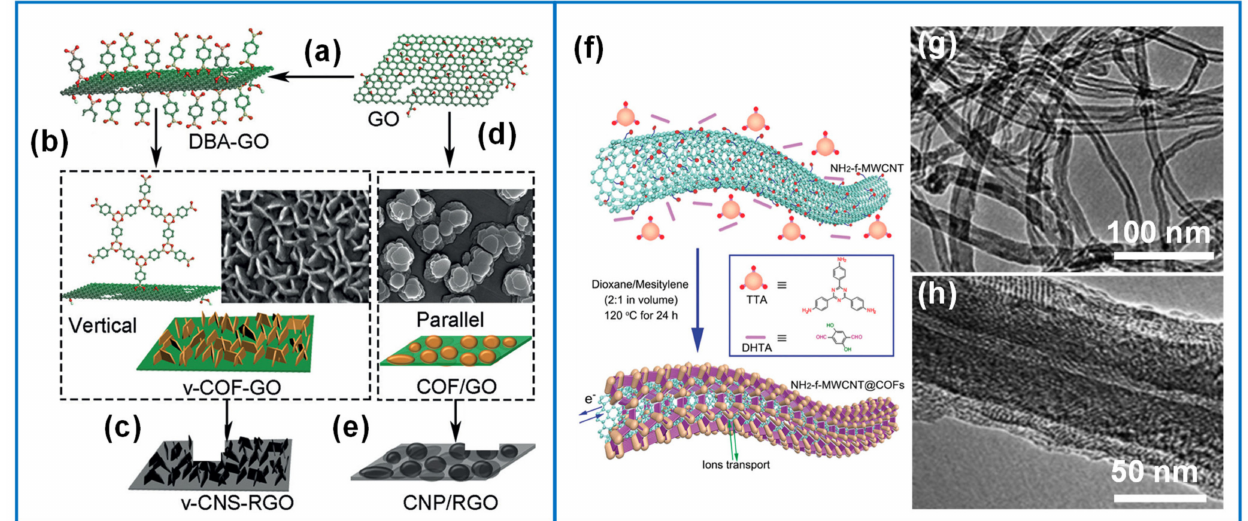
Figure 15. ( a ) Functionalized GO with DBA in methanol. ( b ) Vertical COF nanosheets growth using DBA functionalized on GO dissolved in mesitylene/dioxane (v-COF-GO). ( d ) Parallel COF platelets to GO formation without DBA (COF/GO). Carbonization of ( c ) v-COF-GO and ( e ) COF/GO to produce vertically oriented nanosheets (v-CNS-RGO) or parallel to RGO surface (CNP/RGO). ( f ) Schematic of COFTTA–DHTA shells on the NH 2 -f-MWCNT surface. COFTTA–DHTA was constructed from TTA and DHTA via imine linkages. ( g ) NH 2 -f-MWCNT and ( h ) NH 2 -f-MWCNT and COFTTA–DHTA synthesized at 10 mg mL − 1 of NH 2 -f-MWCNT at 120 ◦ C for 24 h. Reproduced with permission from Refs.